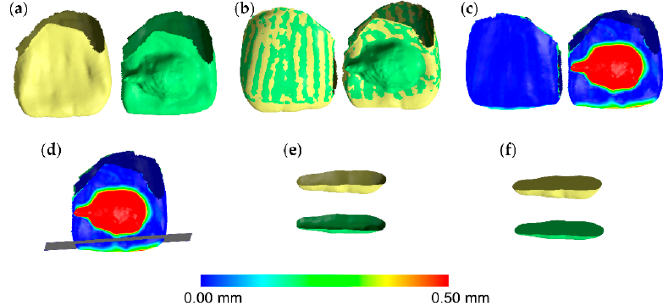
Figure 2. Tooth wear measurement process in a maxillary central incisor. ( a ) Tooth before (yellow) and after (green) tooth wear and retainer simulation. ( b ) Superimposed tooth crowns using the complete crown technique and setting C (20% estimated overlap) shown from the buccal (left) and the lingual (right) aspect. ( c ) Color coded distance map showing the tooth wear from the buccal (left) and the lingual (right) side. ( d ) Level (grey) used to simultaneously slice the two crowns. ( e ) Sliced tooth crowns. ( f ) Holes filled to create watertight models, and thus, calculate volumes.